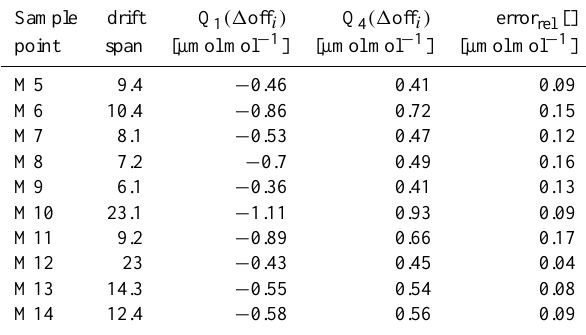
Table 1. Offset statistics and error analysis for ten sample points, i.e. ten analyzers, demonstrating the correction potential of the bias correction approach (“drift span”), typical values for the maximum error possibly attributed to the bias correction approach for a “worst and their ratio, i.e. the relative error error rel according to Eq.(6). See Sect.2.7 for definition of the terms.